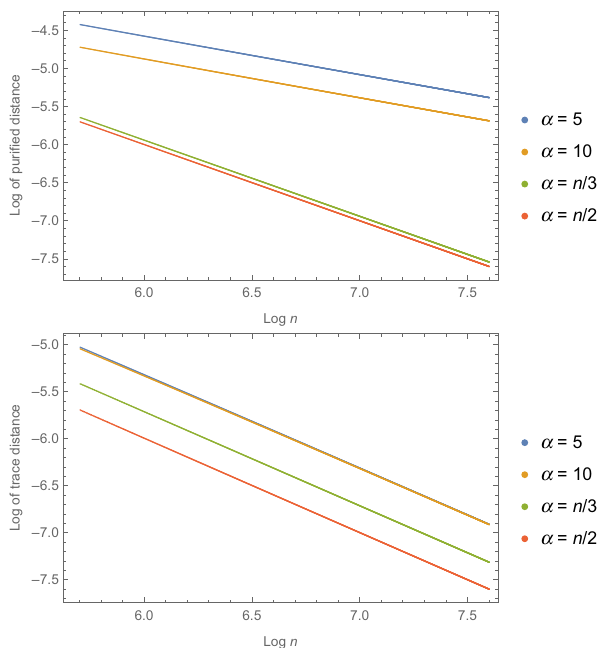
FIG. 1. Log-log plots of the symmetry term in Eq. (32) as given by the trace distance and the purified distance for different α (here we set k = t = 2).